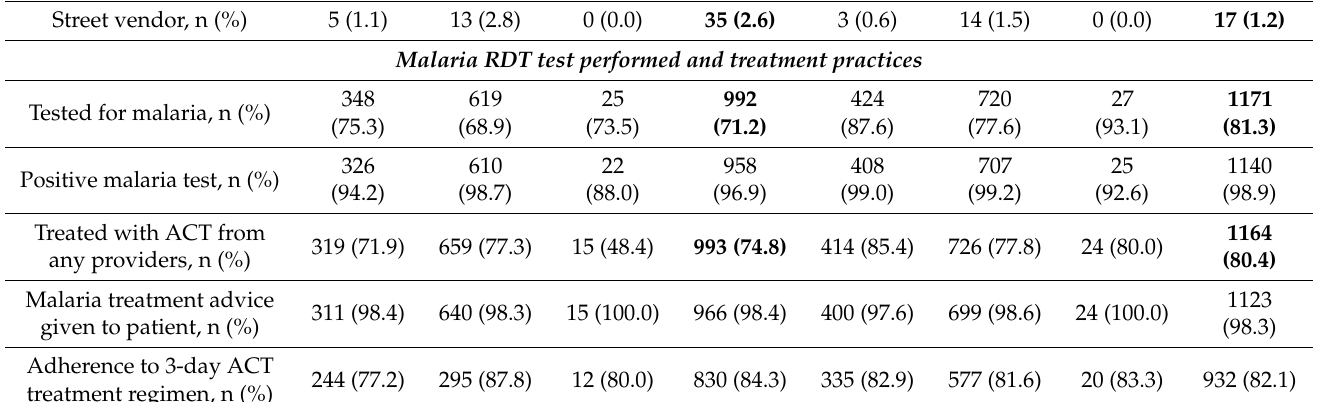
Malaria RDT test performed and treatment